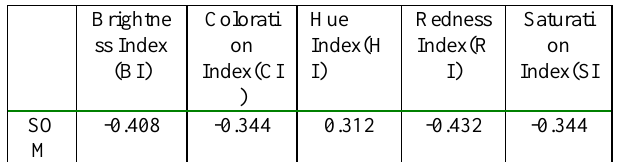
Table 3: Pearson’s correlation coefficient between soil organic matter (SOM) and image color index.